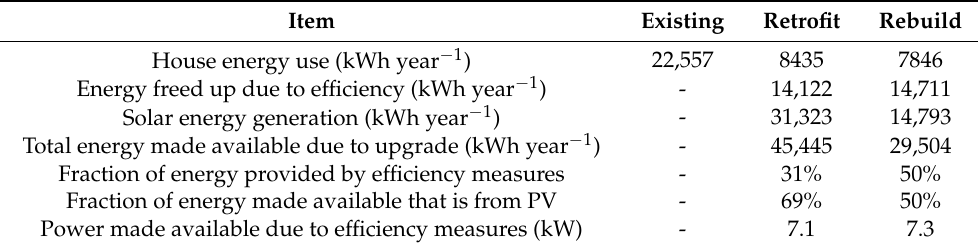
Table 4. Energy and peak power that is made available from retrofitting/rebuilding a single-detached house.